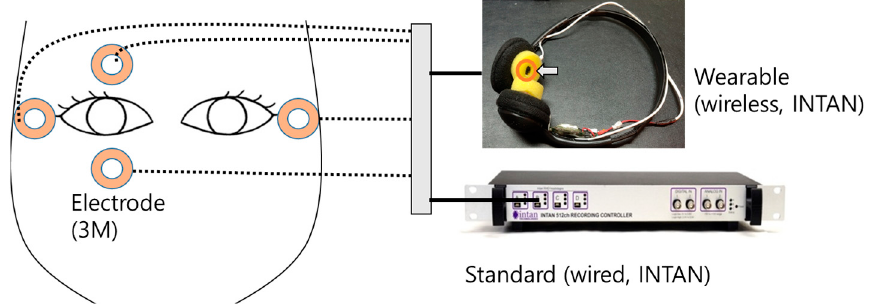
Figure 5. EOG recording standard and wearable with 3M disposable ECG electrode patches.